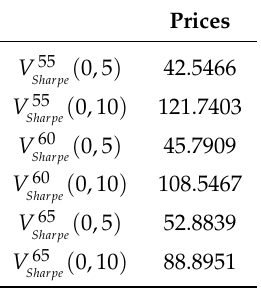
Table 10. The prices of the different individual S-forward contracts under Sharpe approach.